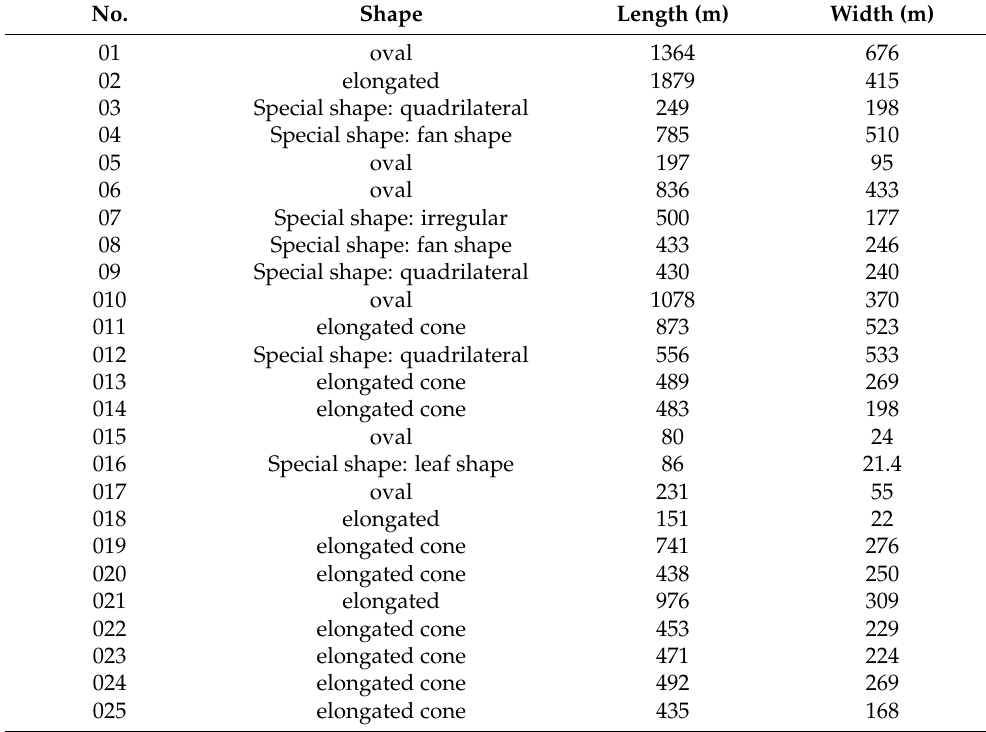
Table 1. Detailed measurements of modern sandbars.